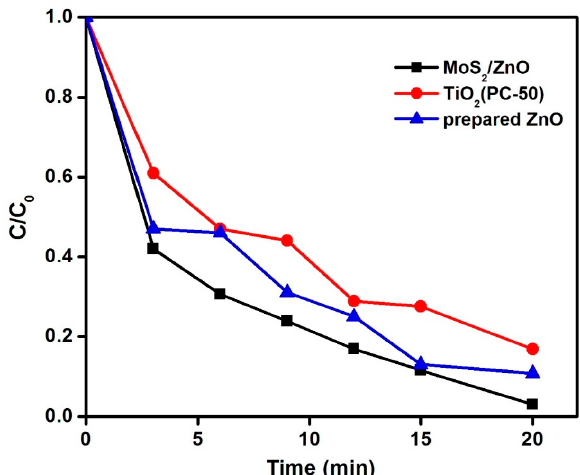
Figure 10. Co mparison of MoS 2 /ZnO heterostructure, pure ZnO, and TiO 2 PC-50 for the removal of MB under natural solar light ( pH 11, catalyst dose: 0.15 g/L, and 10 mg/L aqueous MB solution) .